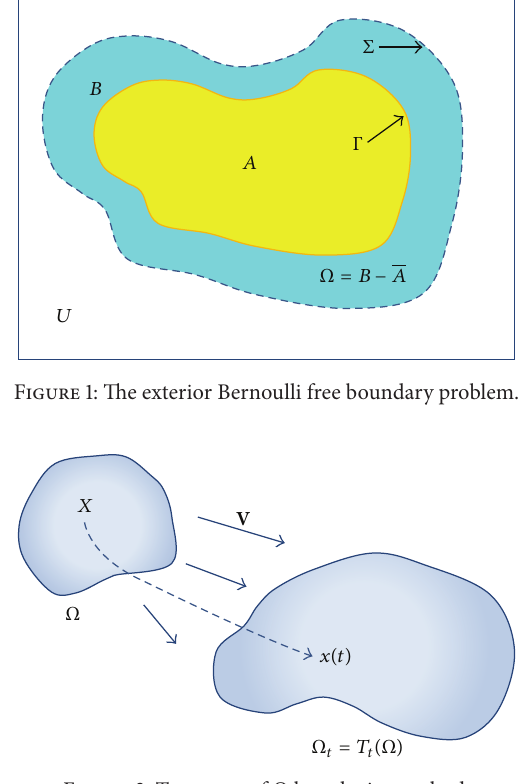
Figure 2: Transport of Ω by velocity